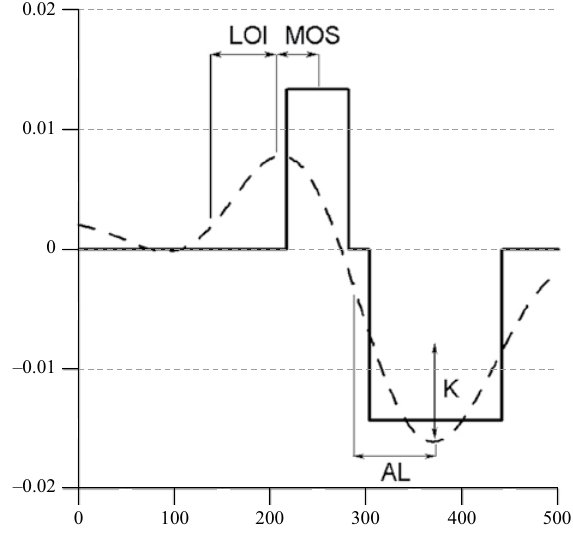
Fig. 2. Relationship between LOI , MOS , AL and